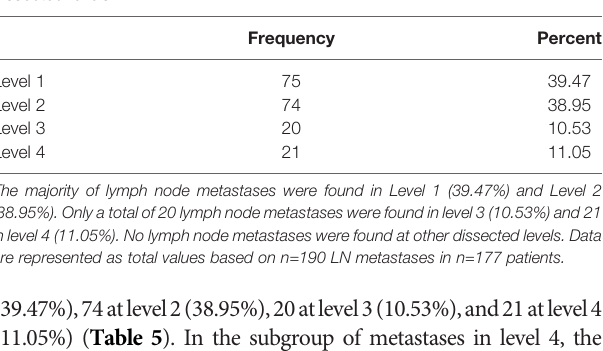
TABLE 5 | Number of cervical lymph node metastases distributed according to dissected levels.